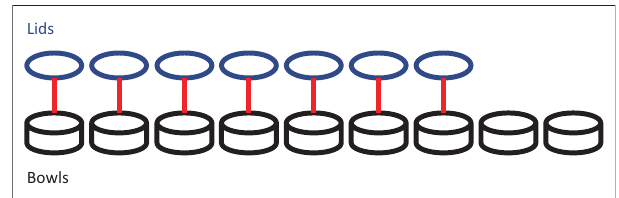
FIGURE 6: Depiction of teacher’s sketch of 9 bowls and 7 lids.